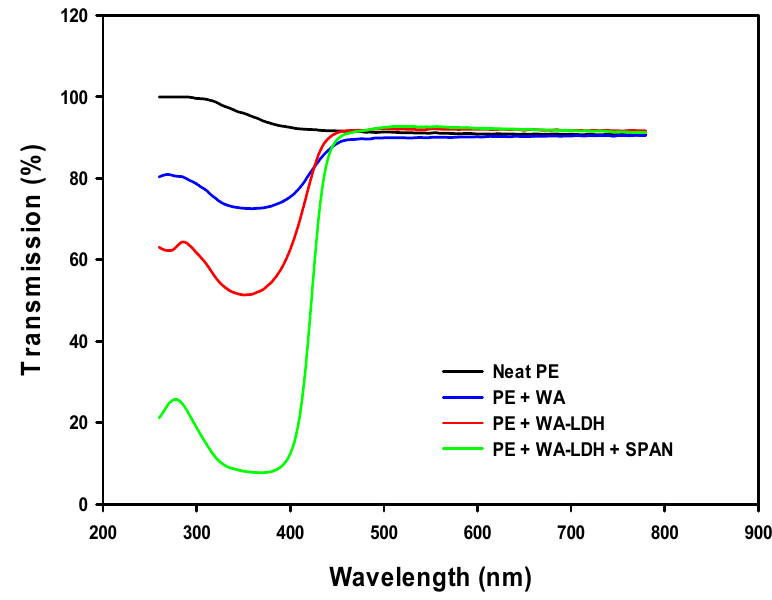
Figure 8. UV–VIS spectra of films made of neat PE, PE with whitening agent, and PE with WA-LDH.